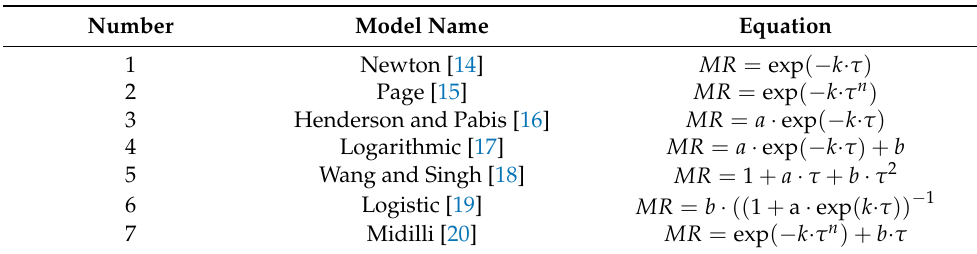
Table 1. Models taken advantage for description of course vacuum freeze drying, vacuum, convective and microwave-convective drying. Number Model Name